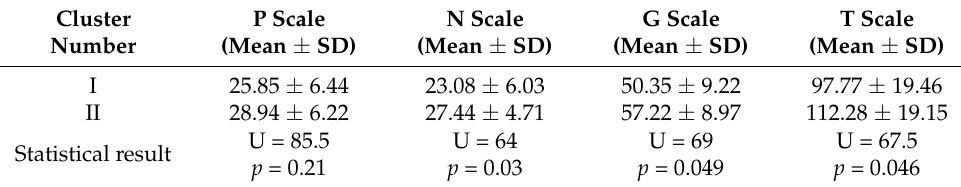
Table 2. Descriptive statistics on the quality of life of the two separate clusters of